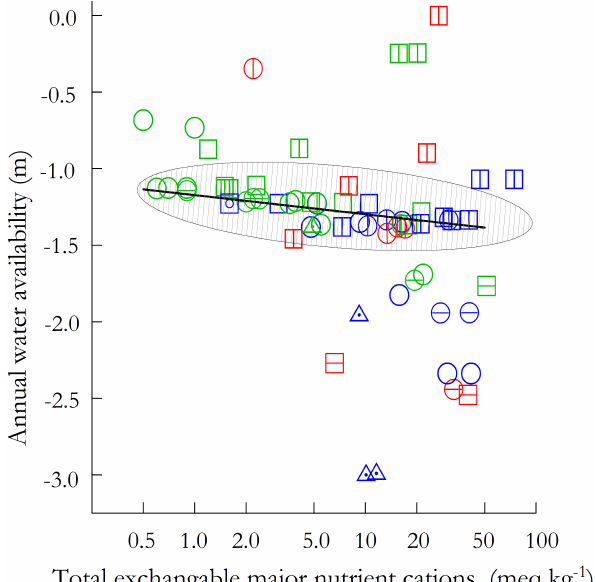
Figure 10. Location of sample plots in relation to their mean annual cumulative soil water deficit (defined as in Eq. 3) and exchange- able nutrient cation content for the top 0.3m of soil (Eq. 4). Sym- bols as in Fig. 1. The ovoid encompasses all sites located within zones of transition as shown in the grey shading of Fig. 8 through which is also shown the best fit standard major axis regression line. Blue symbols: Africa; Green symbols: South America; Red sym- bols: Australia.